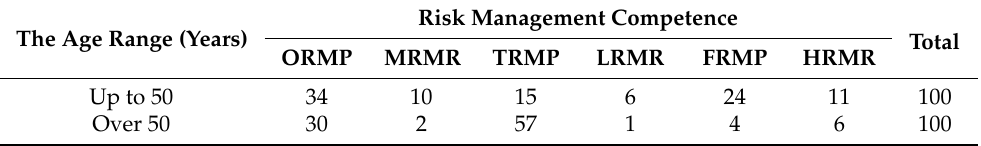
Table 4. Percentage distribution of risk competencies according to the age of management staff. The Age Range (Years)